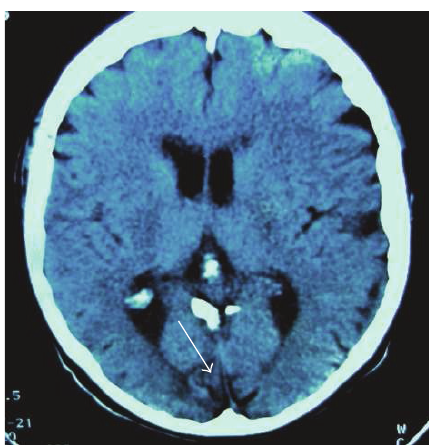
Figure 4: A CT image of the ischemic changes in the right occipital region.